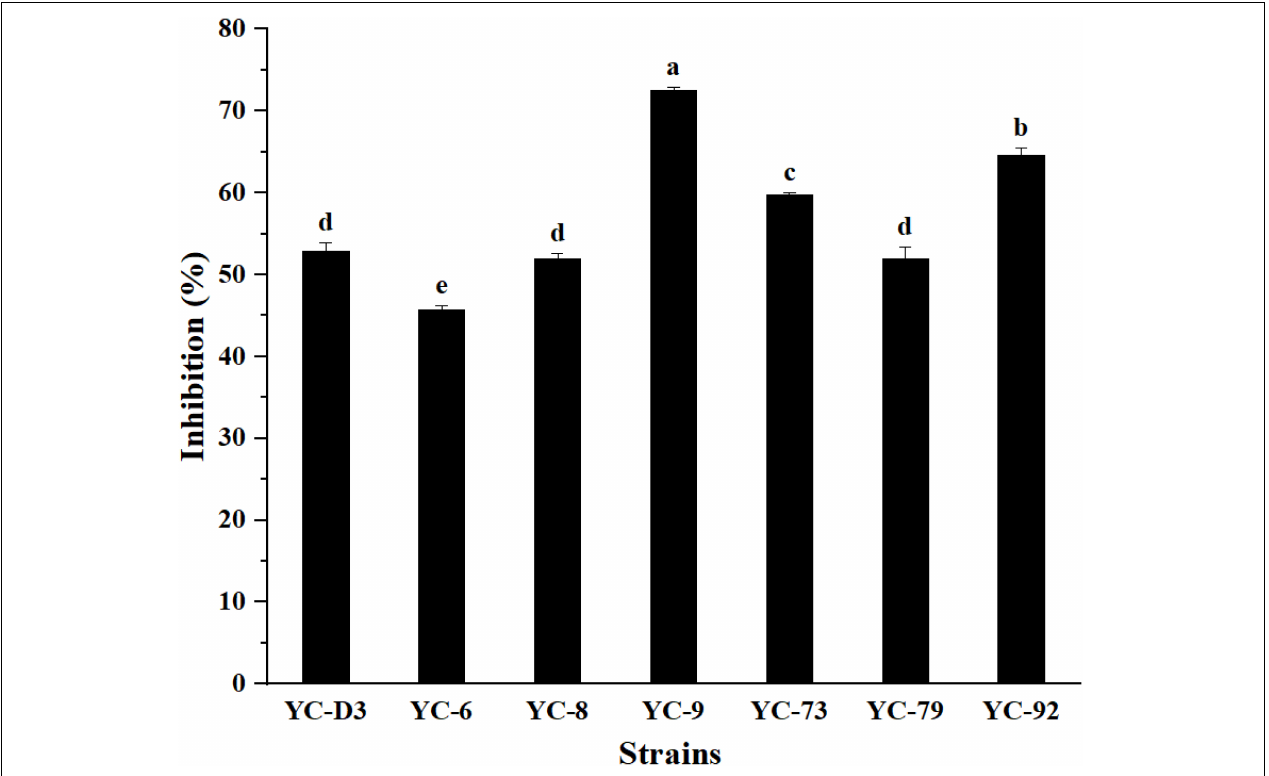
FIGURE 1 | The inhibitory efficiency of seven bacterial strains against FOC. Bars with the same letters are not significantly different according to Duncan’s multiple range test at P < 0.05. Error bars represent the standard deviation from three